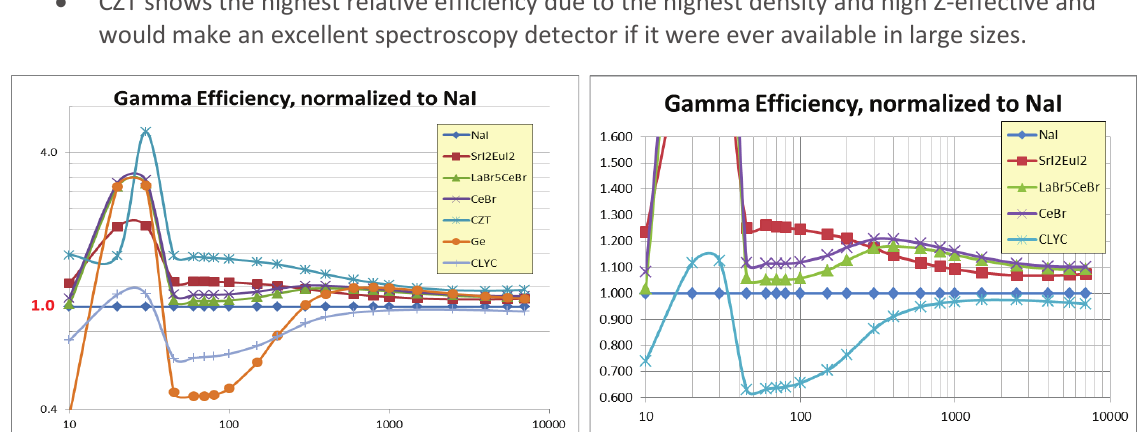
Figure 2 Gamma efficiency for equal size detectors, all normalized to NaI efficiency. The graph on the right is a vertically expanded scale of the graph on the left, and only for the enhanced resolution scintillators discussed in this document.